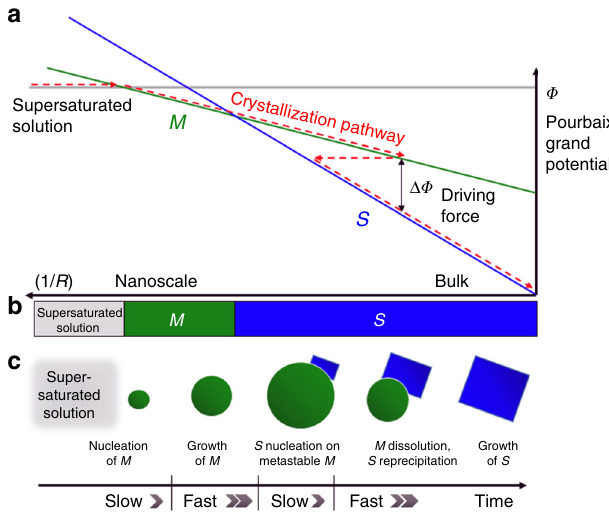
Fig. 1 Schematic representation of remnant metastability in a crystallization pathway. a Free-energy of three phases (supersaturated solution (gray), M (green), S (blue)) as a function of the surface-area-to-volume ratio, 1/ R ( R is a particle radius). The gray line corresponds to the free-energy of a supersaturated solution, green is a metastable phase M that is size- stabilized by a low surface energy (given by the slope), and blue is the bulk equilibrium phase S , with high surface energy. b Phase diagram in the 1/ R axis created from the projection of lowest free-energy phases. c A multistage crystallization pathway (red arrow in a ) proceeds downhill in energy, but phase transformations are limited by nucleation. Crystal growth of M prior to the induction of S means M can grow into a size-regime where phase M is metastable. S will then nucleate, and quickly grow by consuming M via dissolution-reprecipitation. The characteristic length scale of size- driven phase transitions lies in the 2 nm – 50 nm